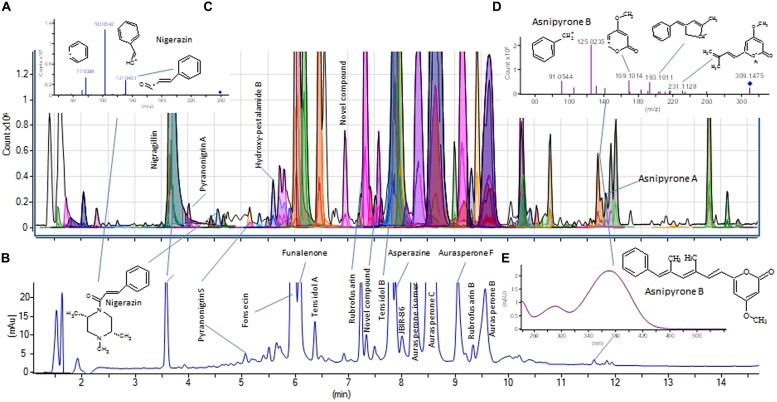
UHPLC-DAD-HRMS-MS/HRMS analysis of an Aspergillus tubingensis extract. (A) shows the BasePeak chromatogram. Peaks automatically assigned from Auto-MS/MS data searched in the MS/HRMS database are colored. (B) shows the UV/Vis chromatogram (200–640 nm), while (C) shows the MS/HRMS spectrum of nigerazin A (20 eV) or B used to tentatively ID this peak. (D) and (E) shows the MS/HRMS (20 eV) and UV/Vis spectra of asnipyrone B, respectively, with the UV/Vis spectrum matching literature data perfectly, and also eluting before asnipyrone A (having an extra methyl group). For instrument settings see Kildgaard et al. (2014).